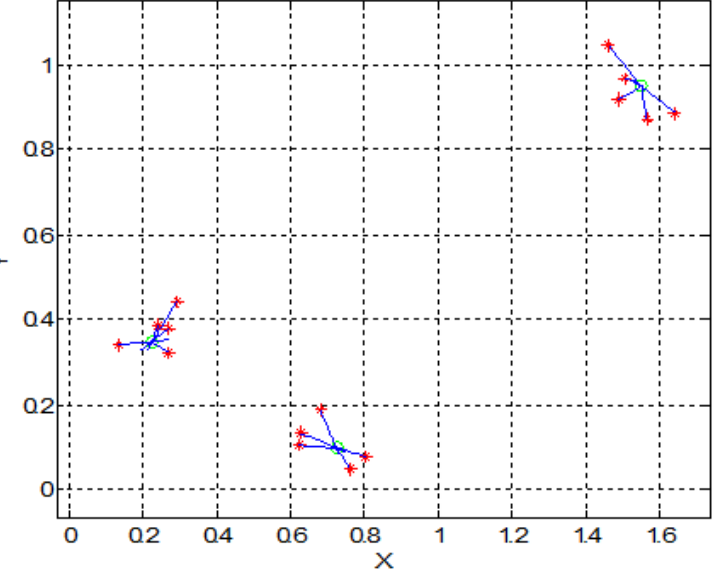
Figure 6. Trajectory of fifteen nanoparticles under three magnetic field sources (units are